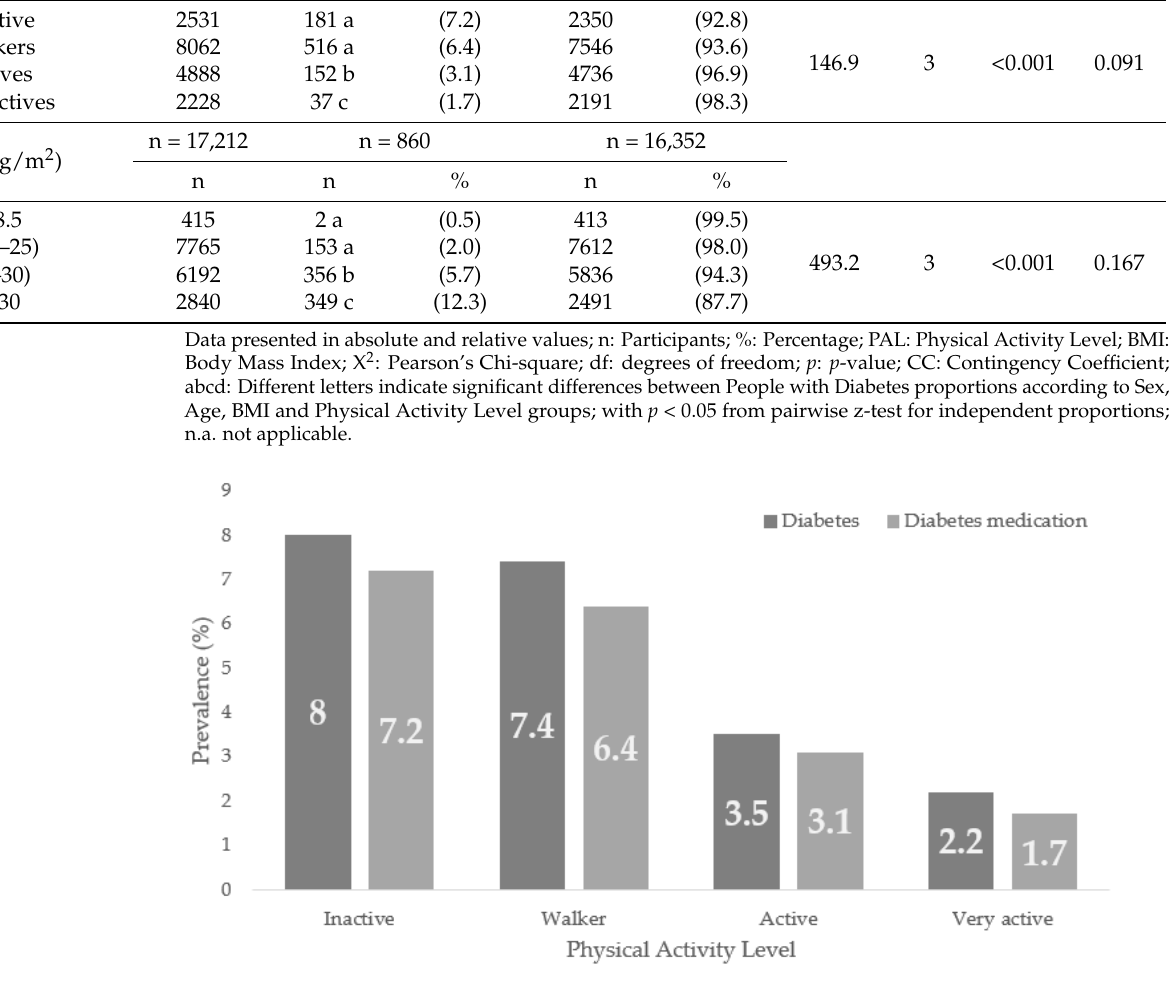
Figure 2. Diabetes and Diabetes Medication use Prevalence According to the Physical Activity Level (PAL) in the ENSE2017.